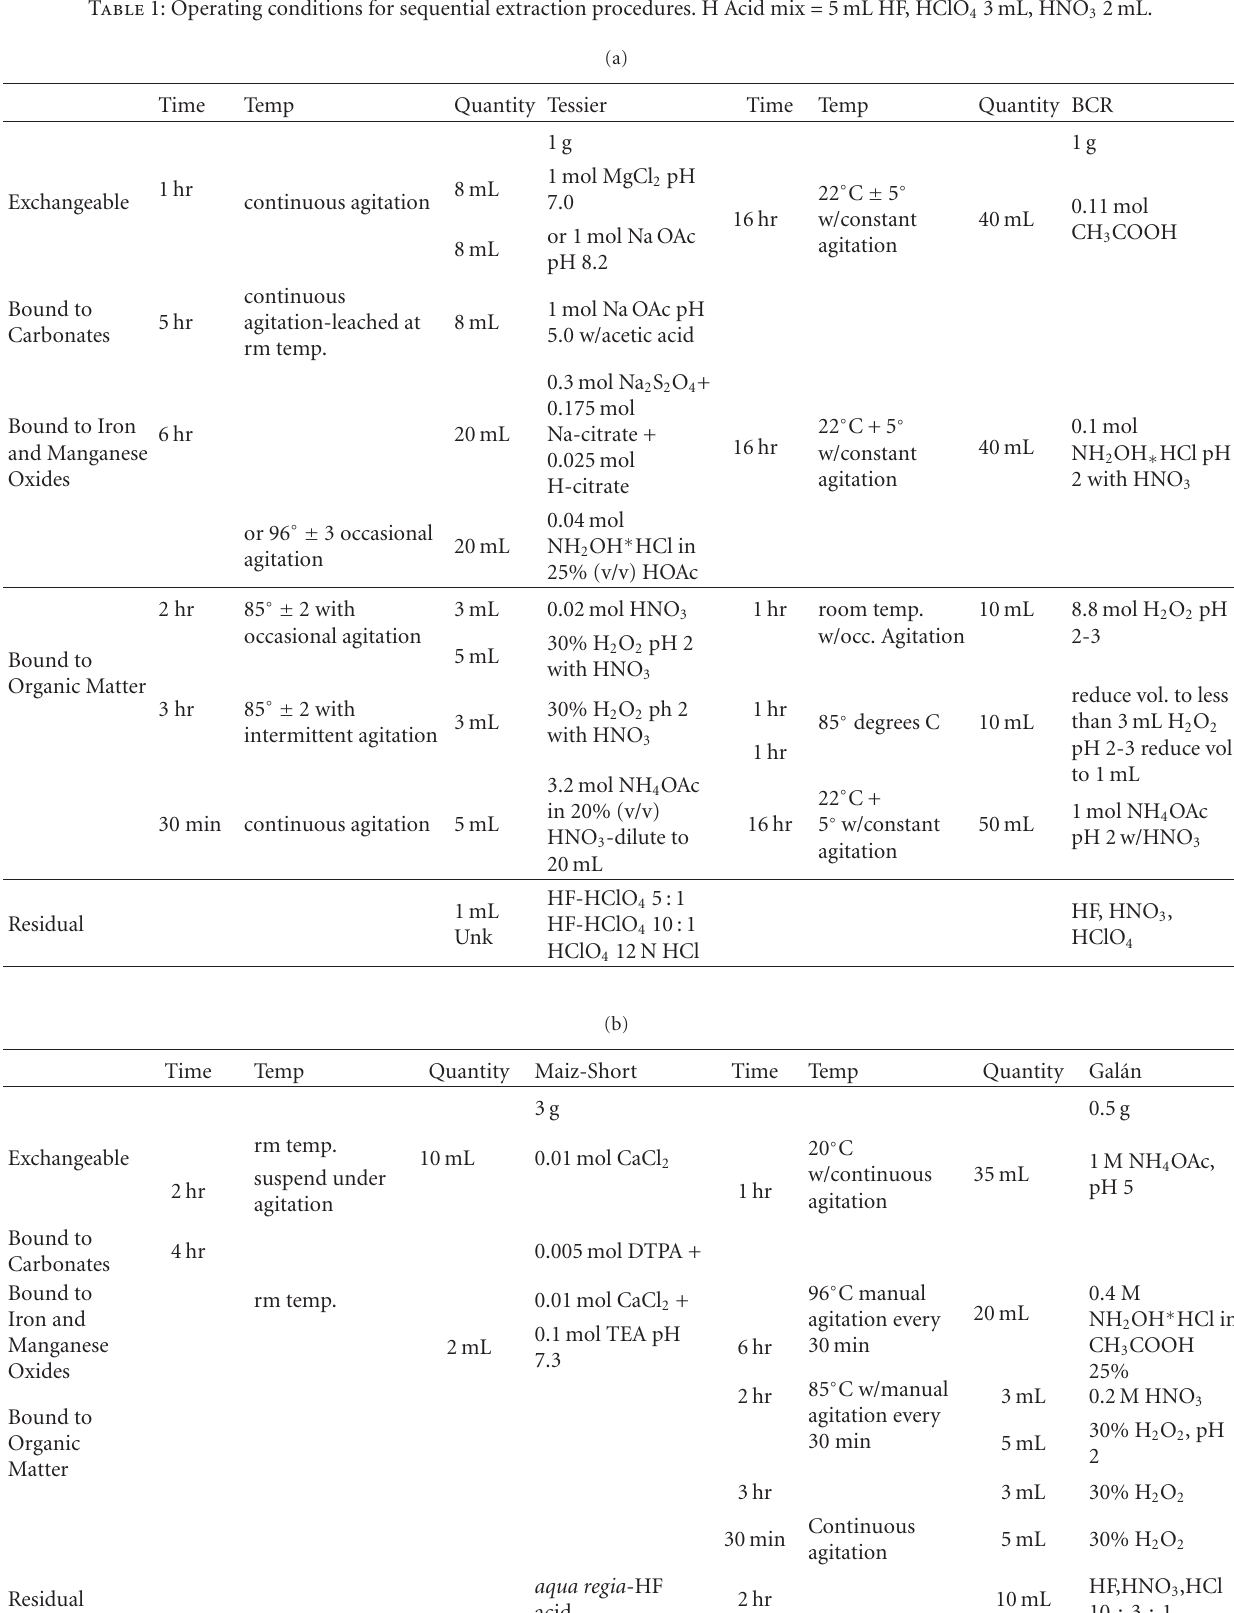
Table 1: Operating conditions for sequential extraction procedures. H Acid mix = 5 mL HF, HClO 4 3mL, HNO 3